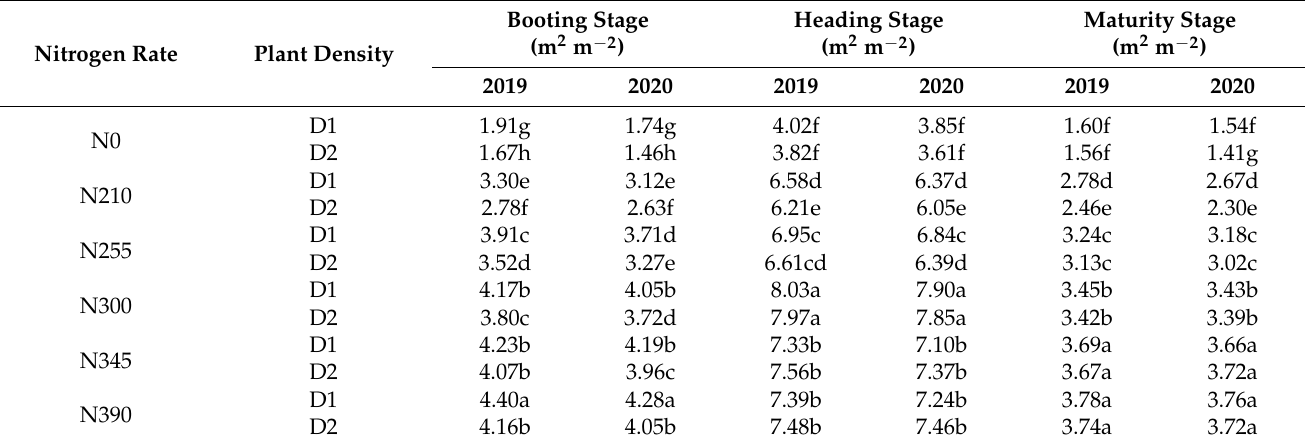
Table 2. Rice leaf area index under combined nitrogen rate and planting density in saline